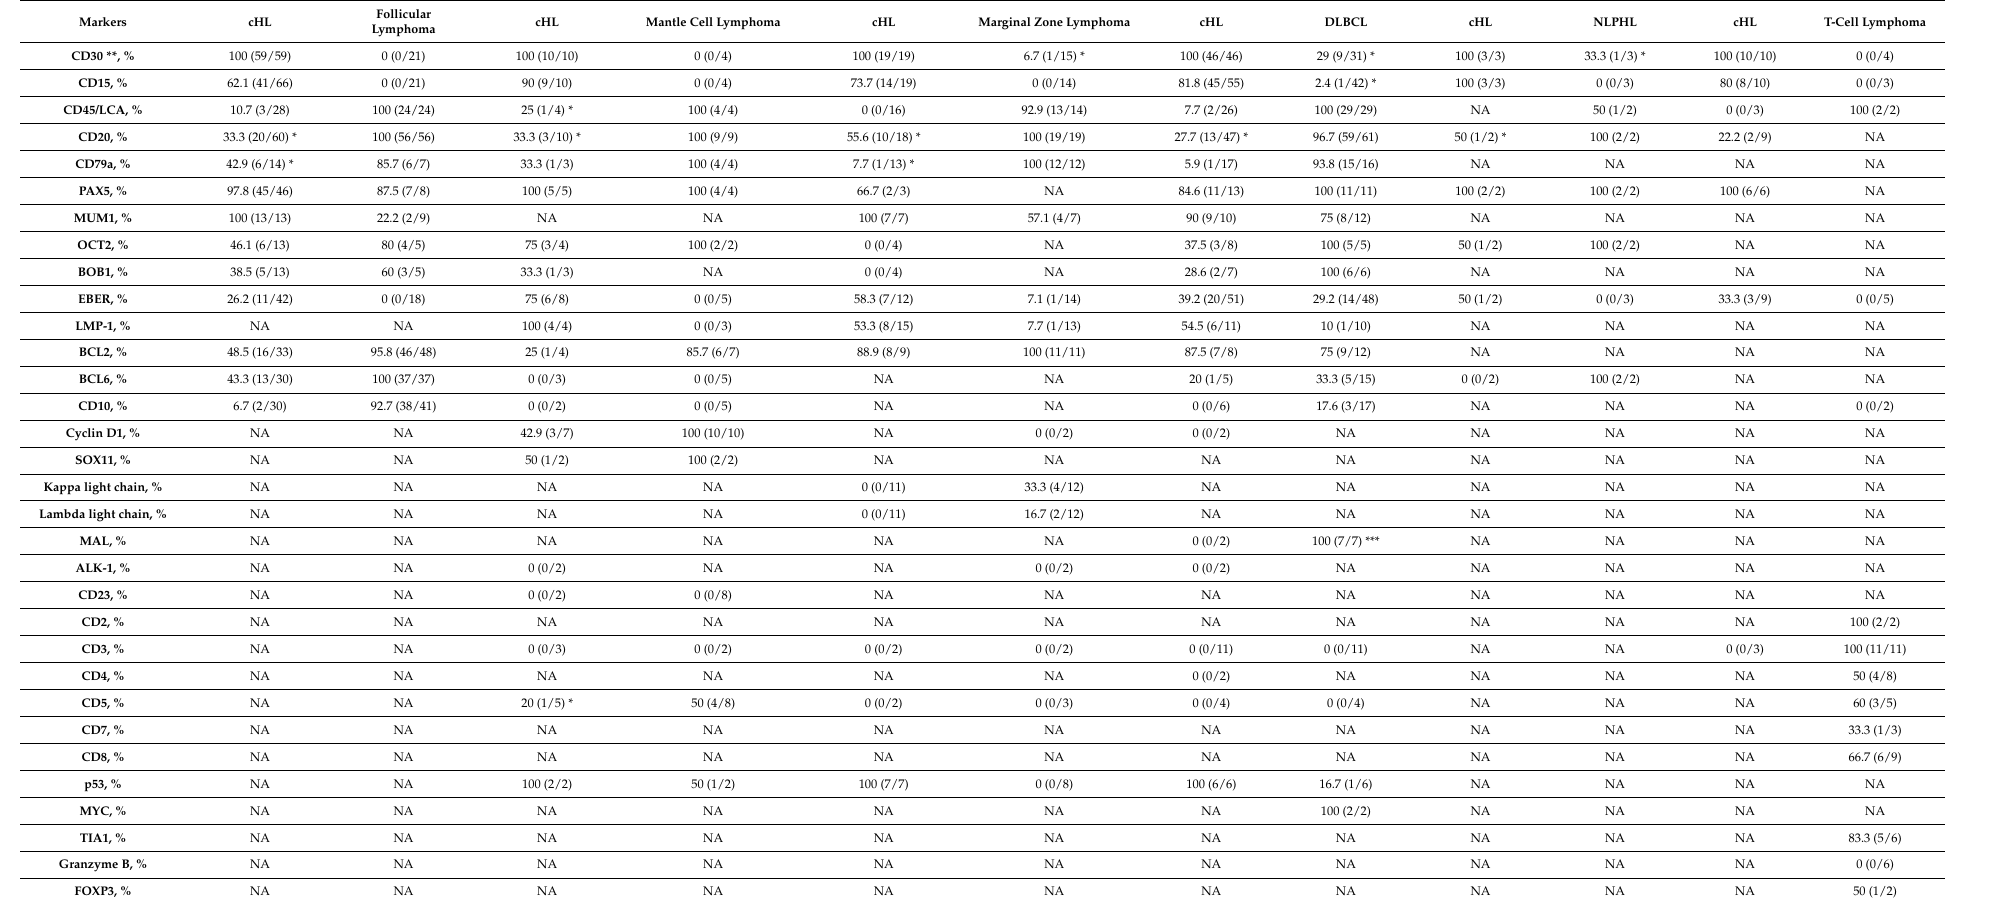
Table 3. Immunophenotype of both contingents in cHL composite